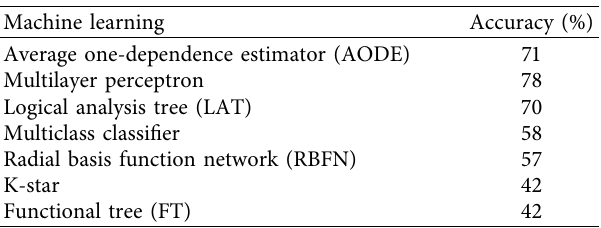
Table 4: Accuracy of machine learning techniques in predicting the mental health problems among